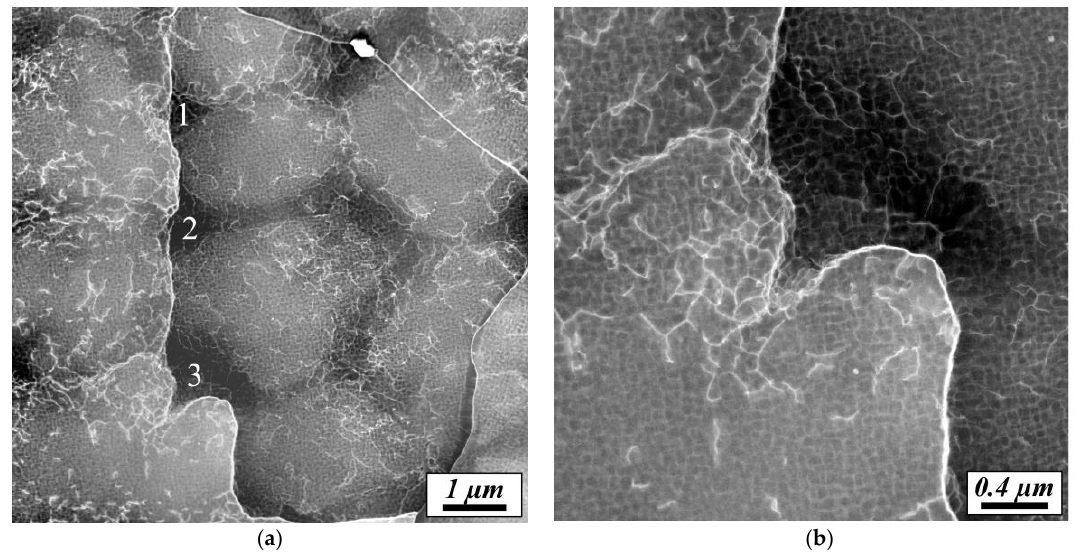
Figure 10. STEM-HAADF micrographs of the dislocation substructure in SEBM Specimen A. ( a ) Small angle boundary which separates two groups of dendrites. The orientation between the two regions left and right of the subgrain boundary is below 3°. ( b ) The recess in the lower part of the boundary in Figure 10a at higher magnification.